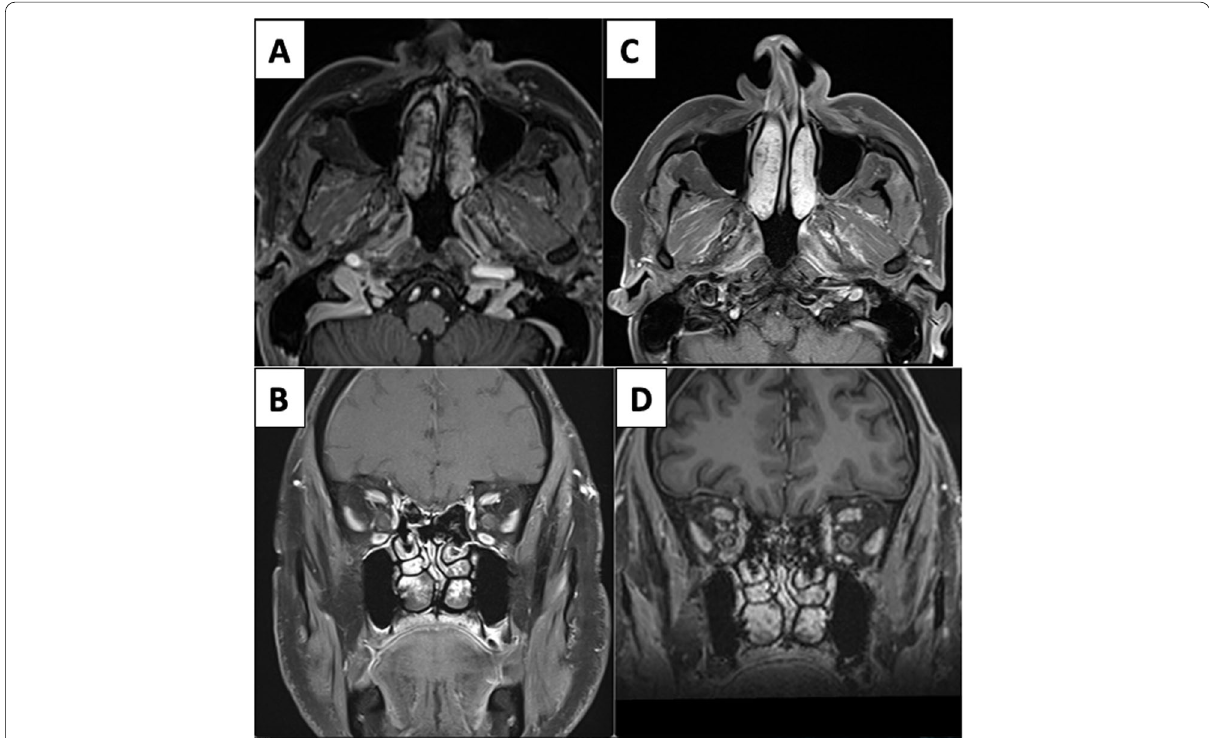
Fig. 1 A , B Dynamic post-contrast axial and coronal scans show non-enhancing dots and striations in bilateralinferior and left middle turbinates on early dynamic post-contrast images. C , D These show progressive enhancement on delayed scans essentially ruling out pathological black